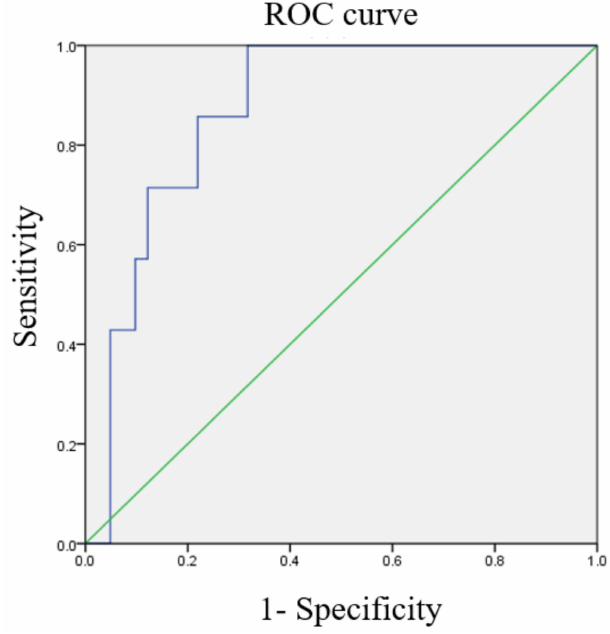
Figure 2. The receiver operating characteristic (ROC) curve of the neutrophil/lymphocyte ratio predicts cancer death (area under the curve [AUC] = 0.871).